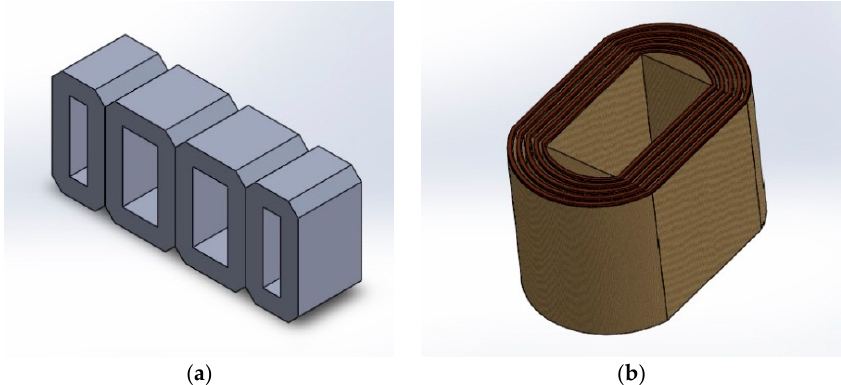
Figure 2. ( a ) Iron silicon part and ( b ) details on the paper and cooper winding.